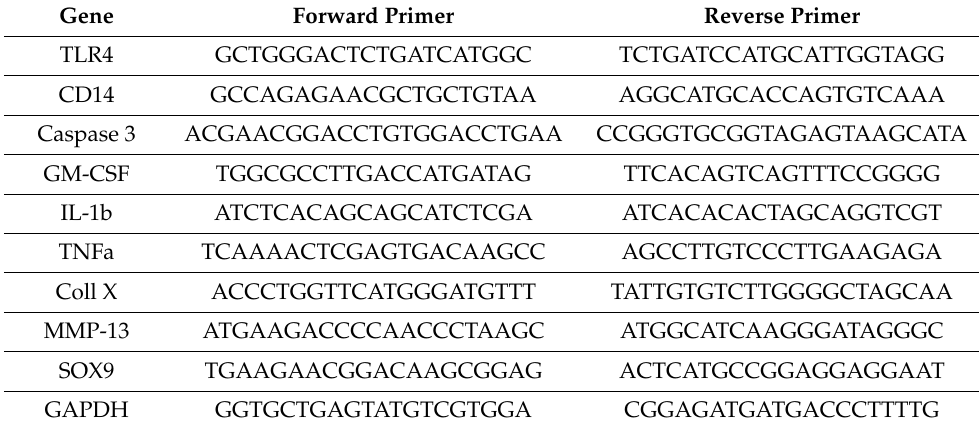
Table 1. Primers used in the